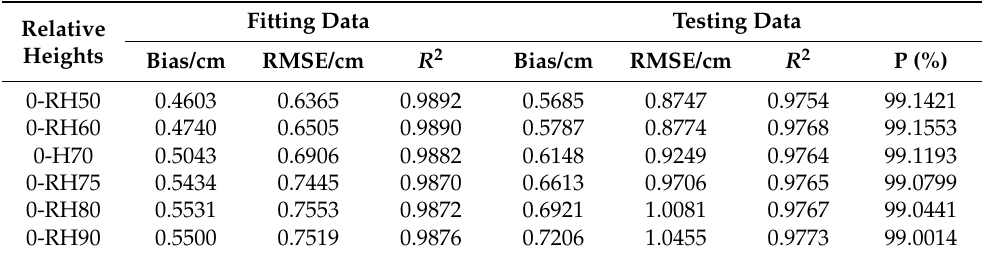
Table 6. Fitting and testing of the taper models with different relative heights. Relative